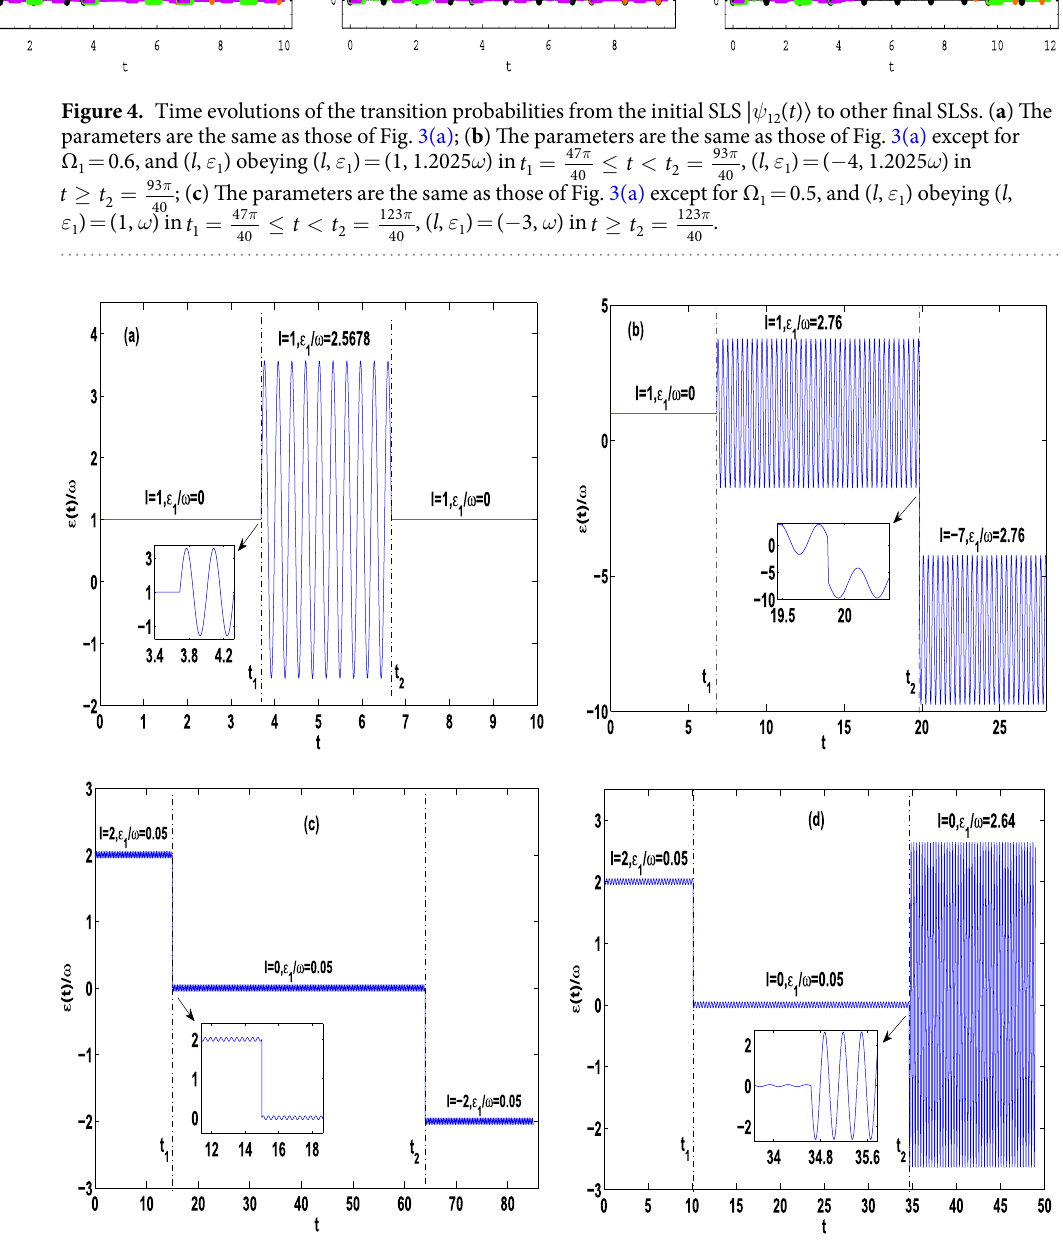
Figure 5. Temporal sequences of the time-dependent bias ε ( t ) with the parameters of Fig. 5(a,b,c,d) being the same as those of Fig. 3(a,b,c,d), respectively, in the corresponding time intervals. The insets indicate the evolution details around several operation times. In ( a ), the driving of amplitude ε 1 = 2.5678 ω is continuously added to the constant bias ε 0 = 1 ω . In ( b , c and d ), the static bias is adjusted between the discrete values 6 , which leads to discontinuous changes of ε ( t